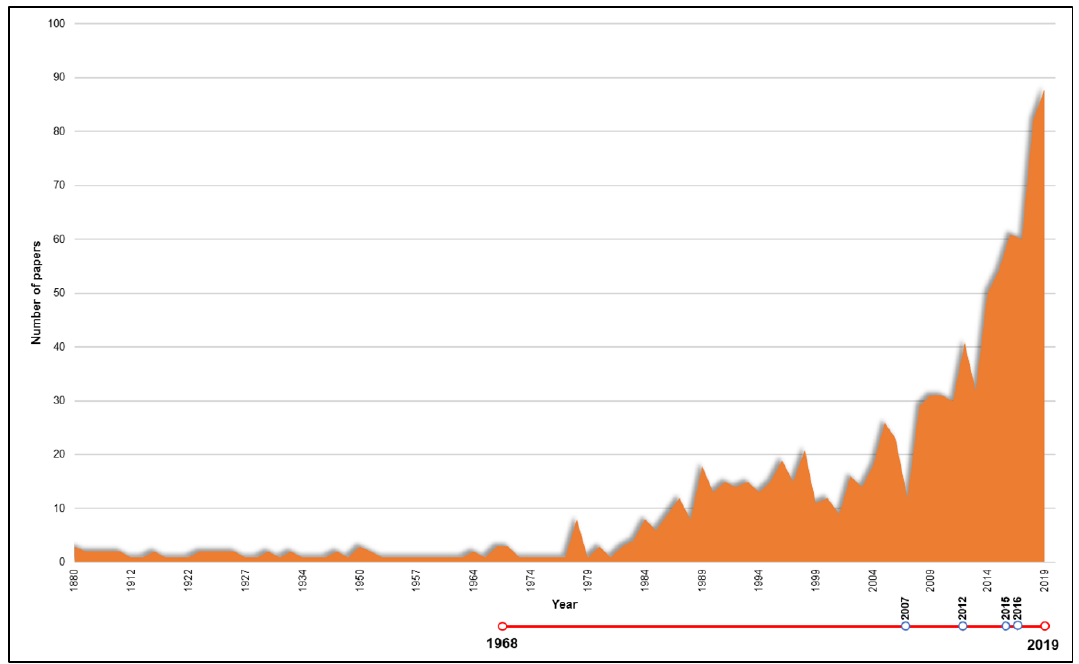
Figure 1. Number of camel research publications from 1880 to 2019. Timeline is represented below the graph in red, with blue-contoured spots marking the moment of release of a regulation document.